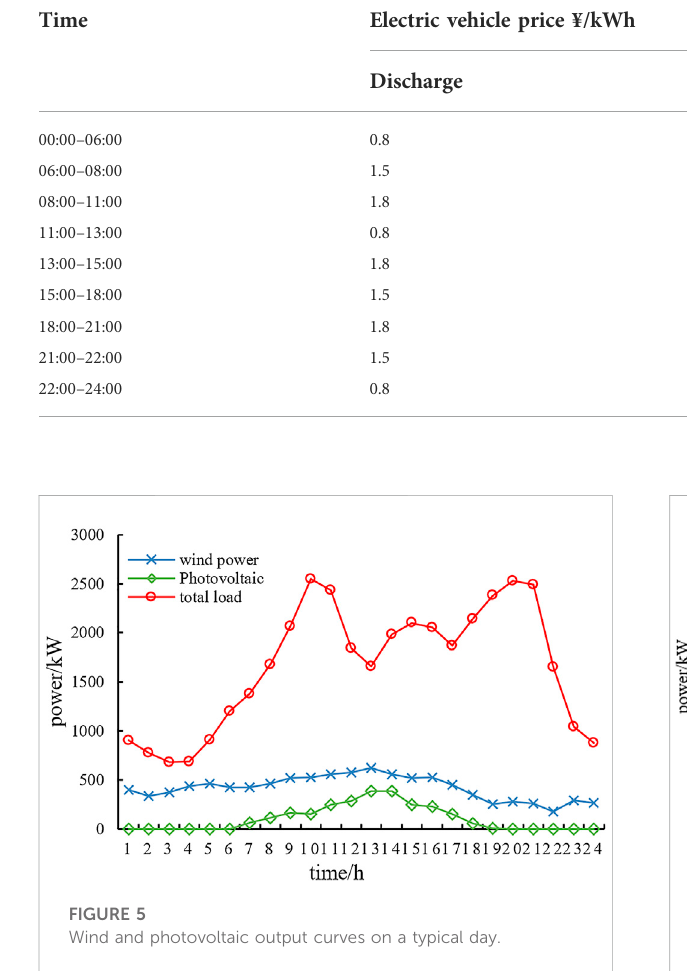
TABLE 2 Electricity for base load and electric vehicle charging and discharging time-of-use prices.